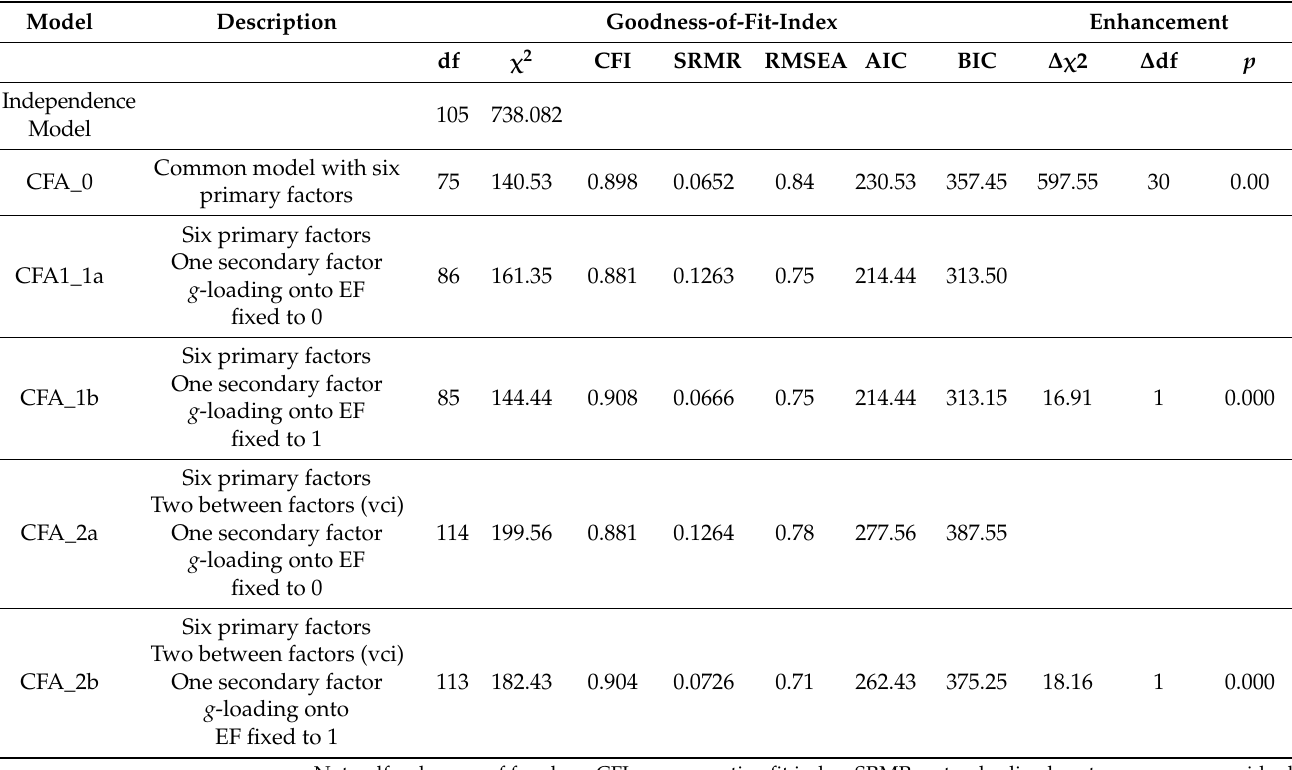
Table 2. Model fit indices of the tested models.